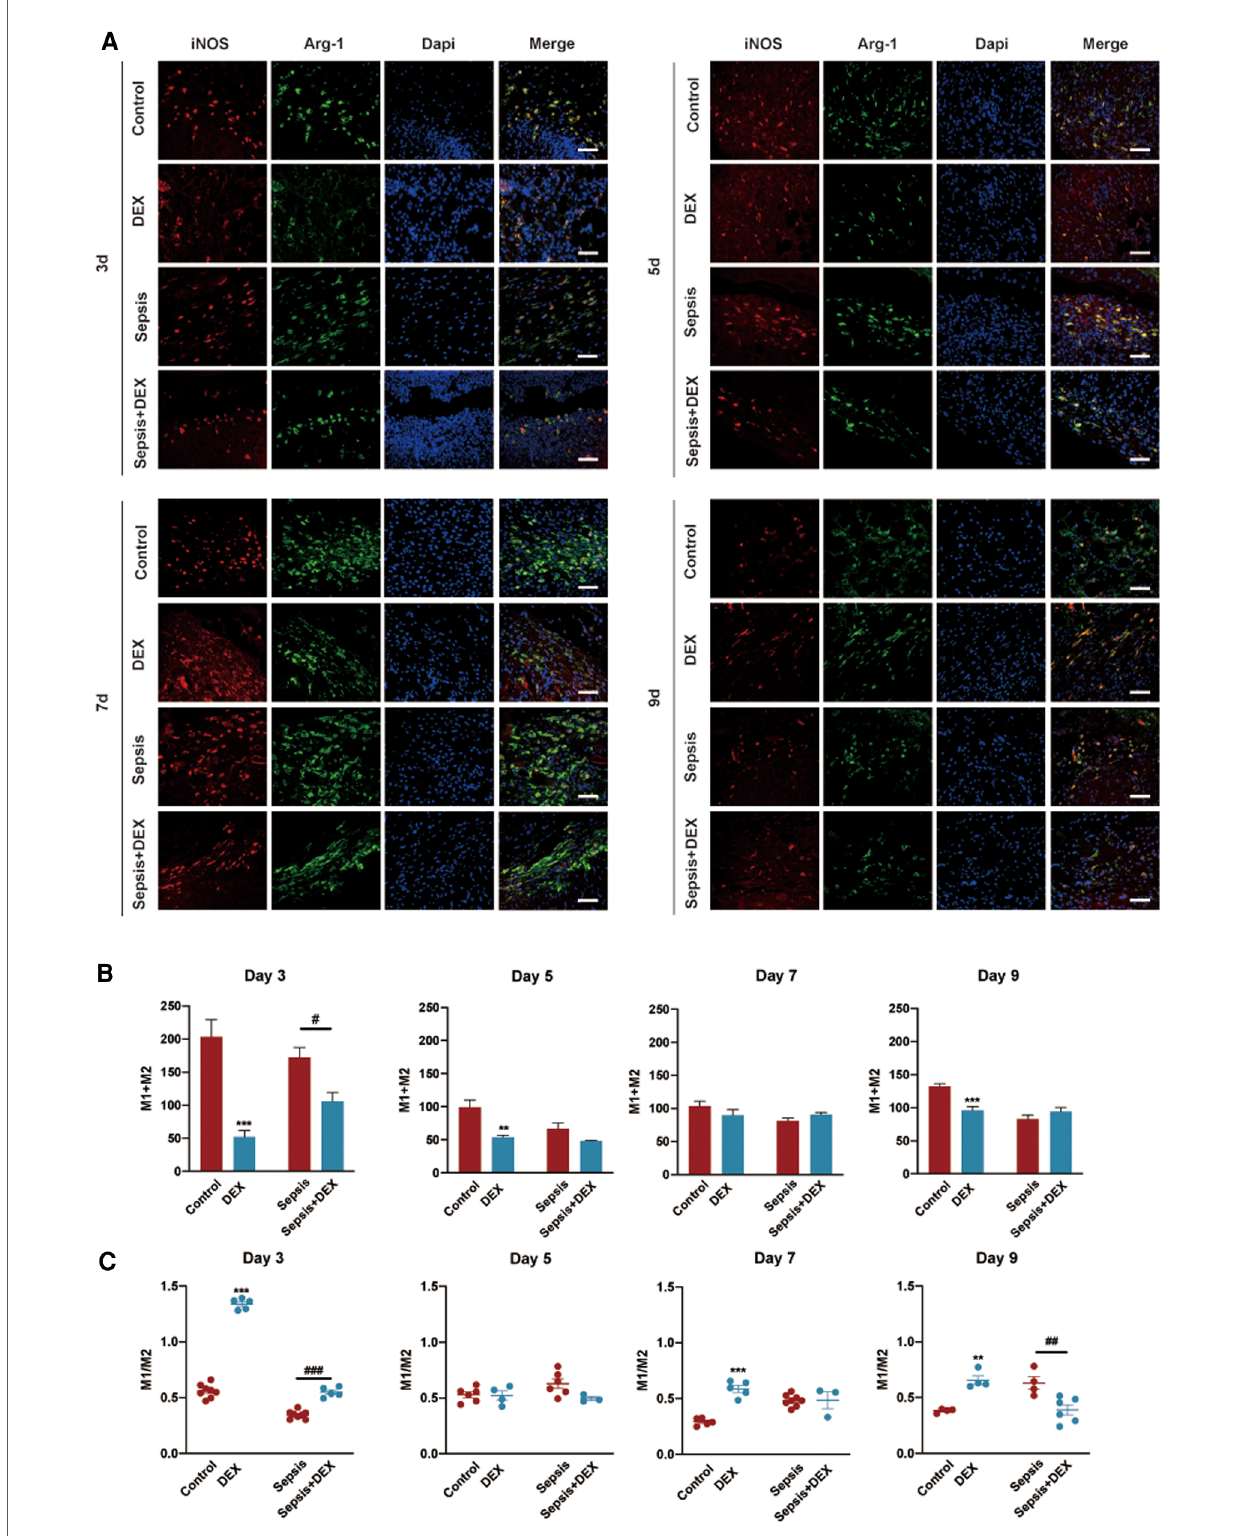
FIGURE 6 The initiation of in fl ammation and subsequent macrophage polarisation towards M 2 relied on adequate M 1 macrophages in early wound healing. Immuno fl uorescence staining analysis of M 1 and M 2 macrophages in wounds in various groups on the 3 rd , 5 th , 7 th , and 9 th day. ( A ) Representative histological slices of wounds stained by immuno fl uorescence: red (iNOS, M 1 macrophages marker), green (Arg-1, M 2 macrophages marker), and blue (DAPI). Scale bar: 100 µm. ( B ) Number of M 1 and M 2 macrophages. ( C ) M 1/ M 2 ratio. ( B,C ) are quantised data of ( A ). All values represent mean±SEM, n >3.* P <0.05, ** P <0.01, *** P <0.001, vs. control group; # P <0.05, ## P <0.01, ### P <0.001 vs. sepsis group. iNOS, inducible nitric oxide synthase; Arg-1,